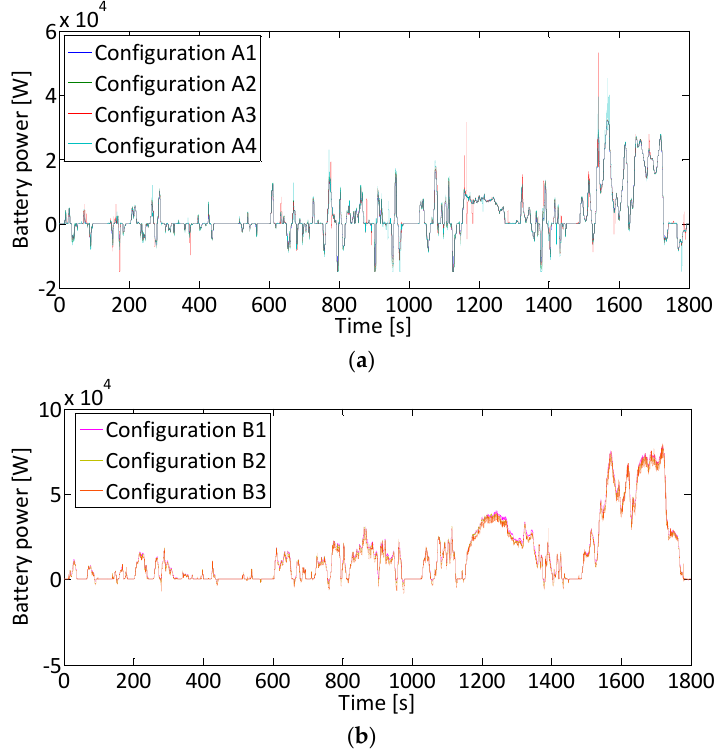
Figure 11. ( a ) Fuel cell output power under Configurations A1–A4; ( b ) Fuel cell output power under Configurations B1–B3.